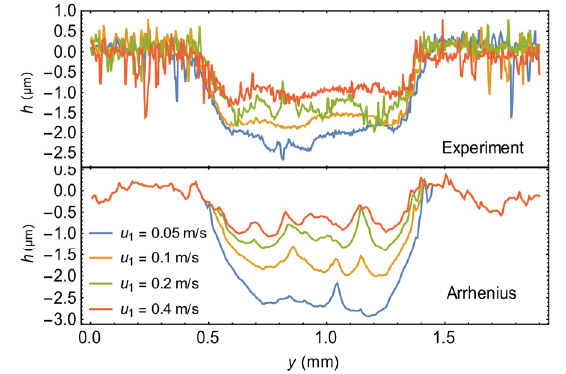
Fig. 10 Comparison of the wear profiles on the center section perpendicular to the speed.